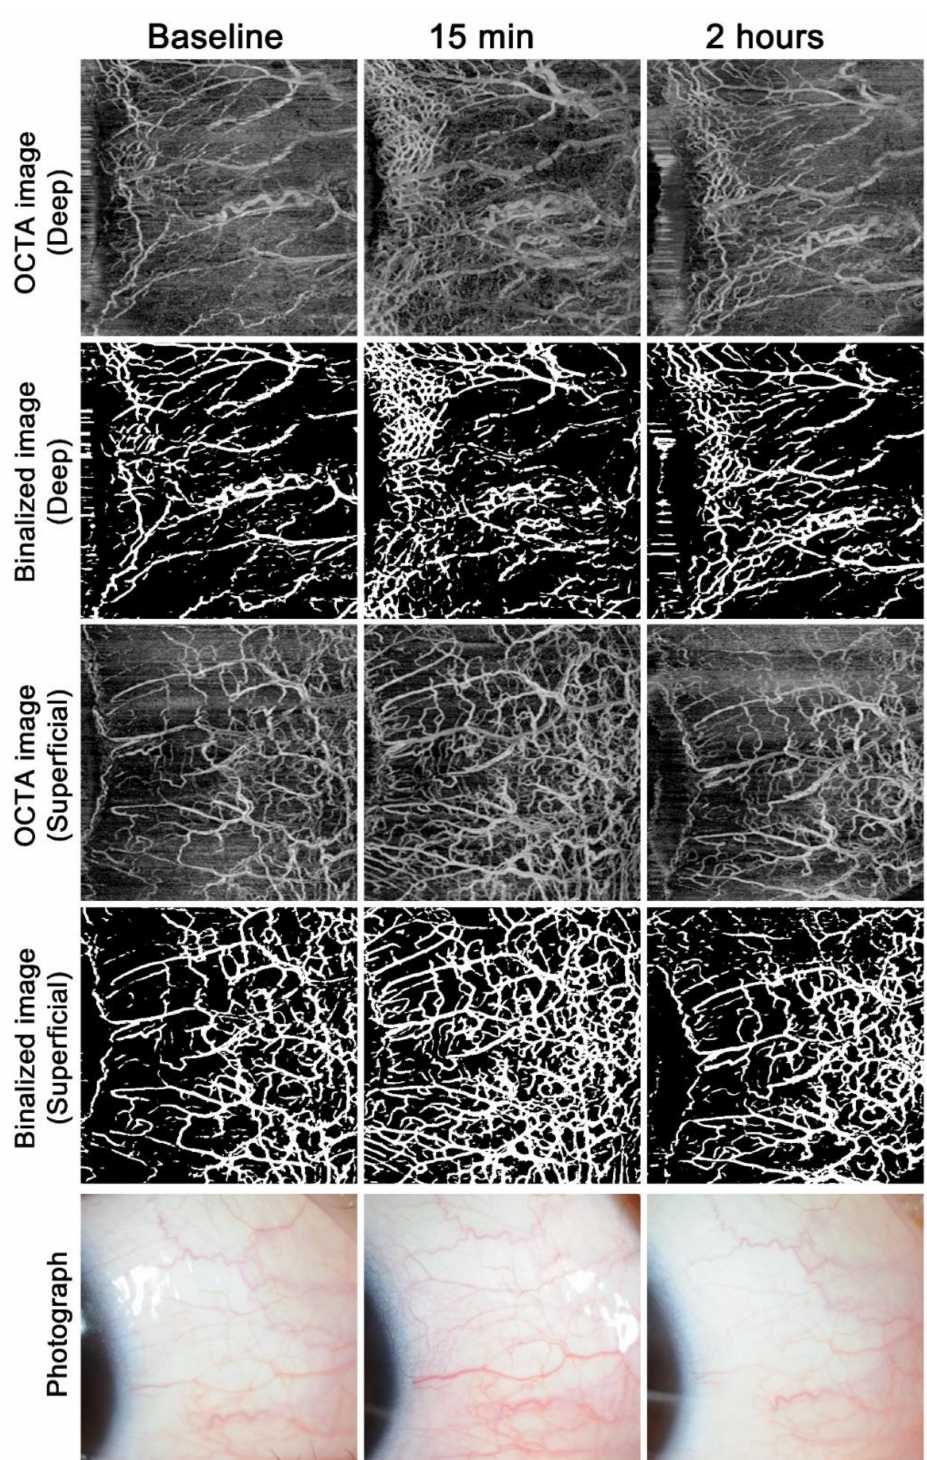
Figure 1. Time course of anterior-segment optical coherence tomography angiography findings and photographs after ripasudil instillation. Example images in the nasal region of the right eye in a normal participant after a single instillation of